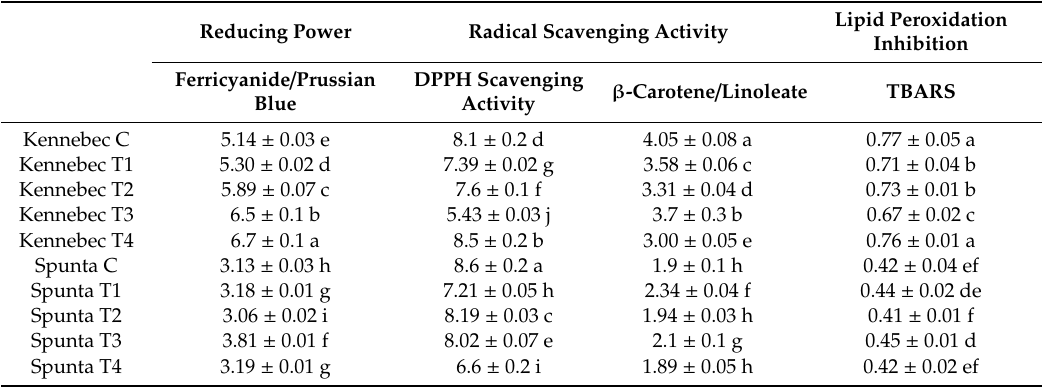
Table 6. Antioxidant properties (EC 50 ; mg / mL) of the studied potato varieties in relation to the fertilization regime.